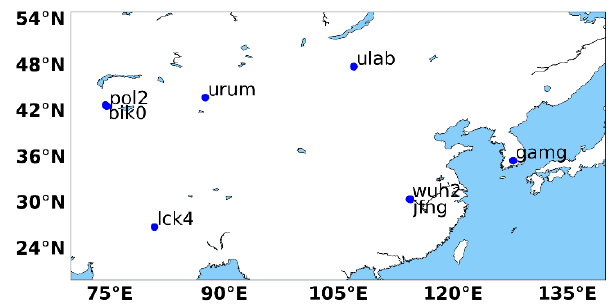
Figure 7. Station distribution used in this paper. Table 1. Baseline information.